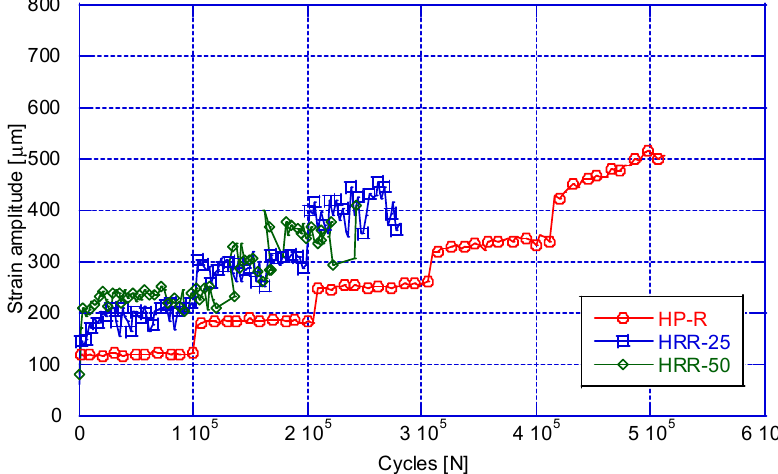
Figure 6. Strain amplitude evolution during a Locati test on the OPC-25CDW mixes.